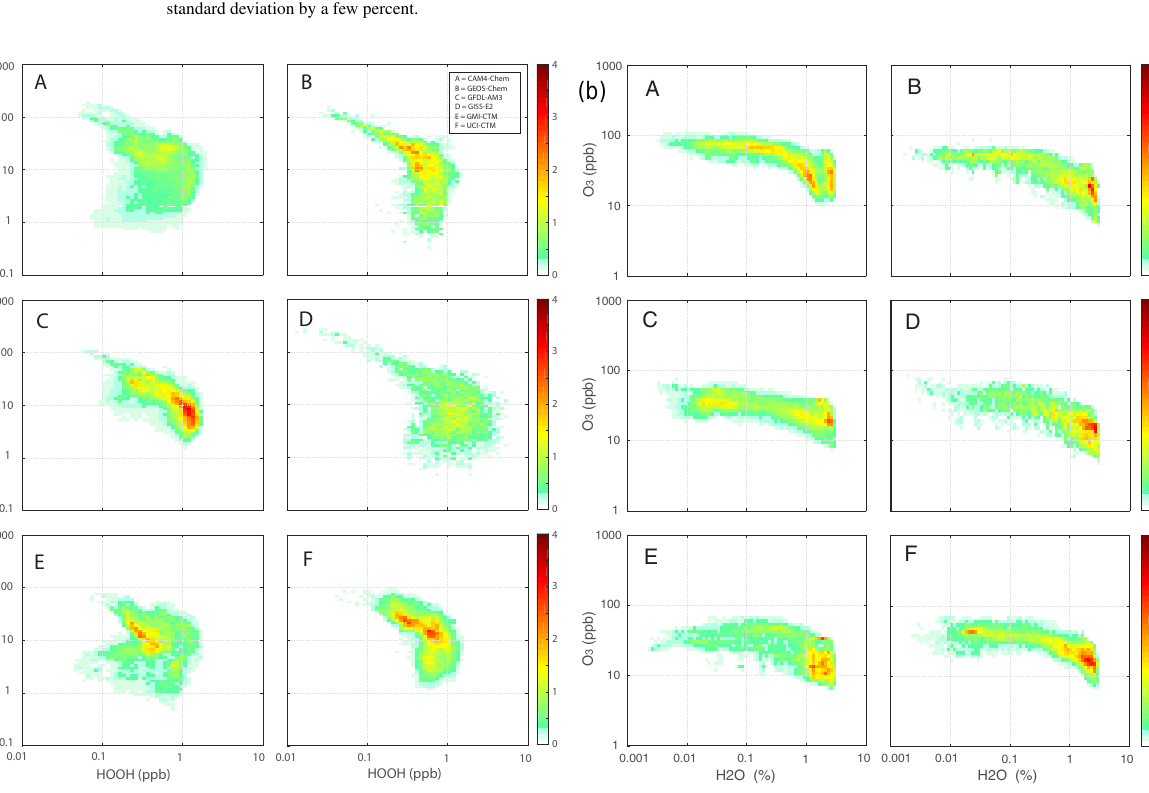
Results are from the UCI-CTM C-runs for 16 August and 1–31 August. The 155–233 ◦ E domain includes 69 longitudinal transects. All tropospheric grid cells in the domain are sampled equally and weighted by mass. The period 1–31 August shows trends in some domains as the sun moves southward, and this was removed with a line fit to calculate the standard deviation over the month. Results for the A-runs (not shown) differ in mean and standard deviation by a few percent.